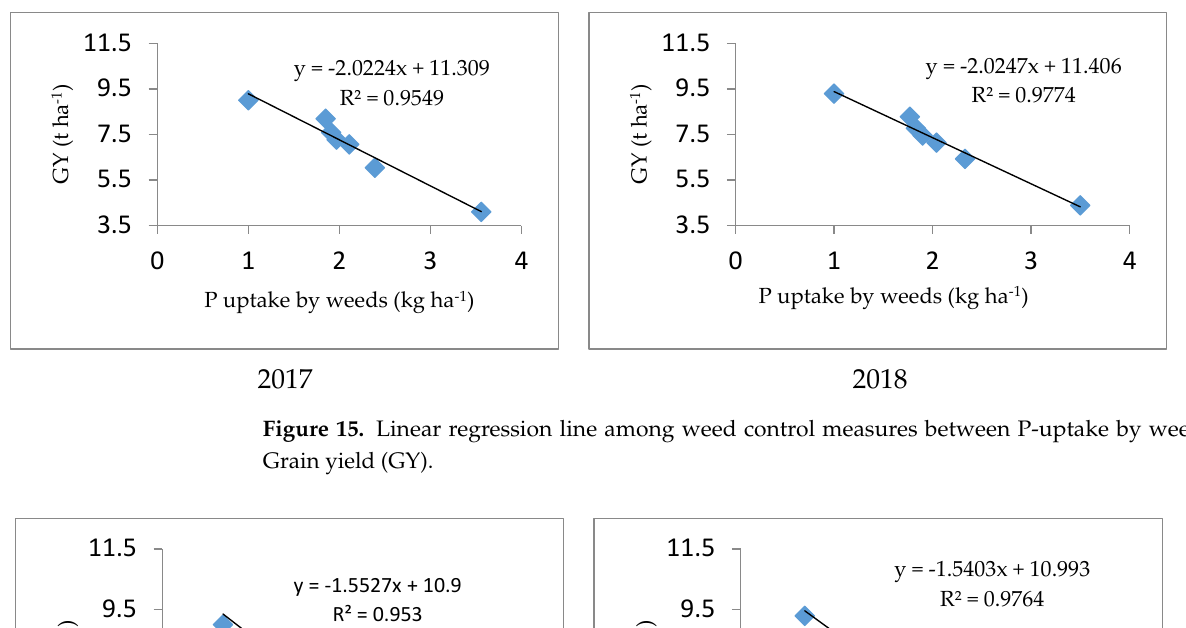
Figure 15. Linear regression line among weed control measures between P-uptake by weeds vs. Grain yield (GY).